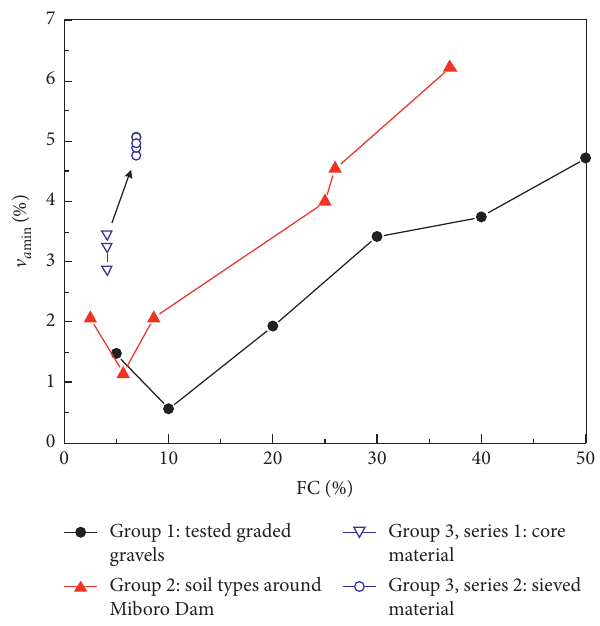
Figure 13: Development of air void ratio v three groups of coarse-grained